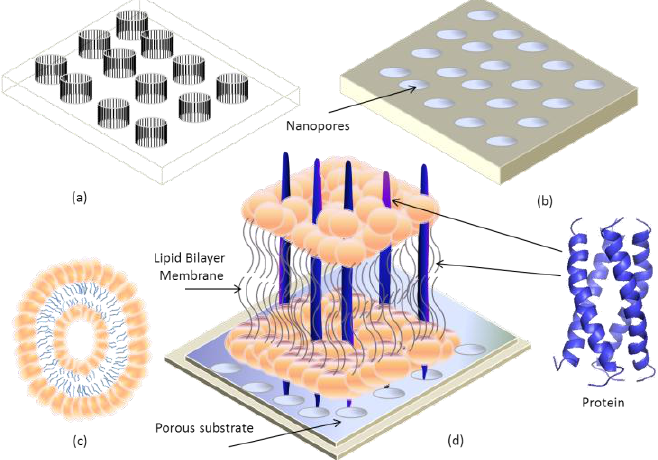
Figure 14. Incorporation of transmembrane proteins fused into lipid bilayer on porous structure. ( a ) Geometry of porous structure; ( b ) Prototype of fabricated porous structure; ( c ) Vesicle; ( d ) Lipid bilayer membrane on PSi.